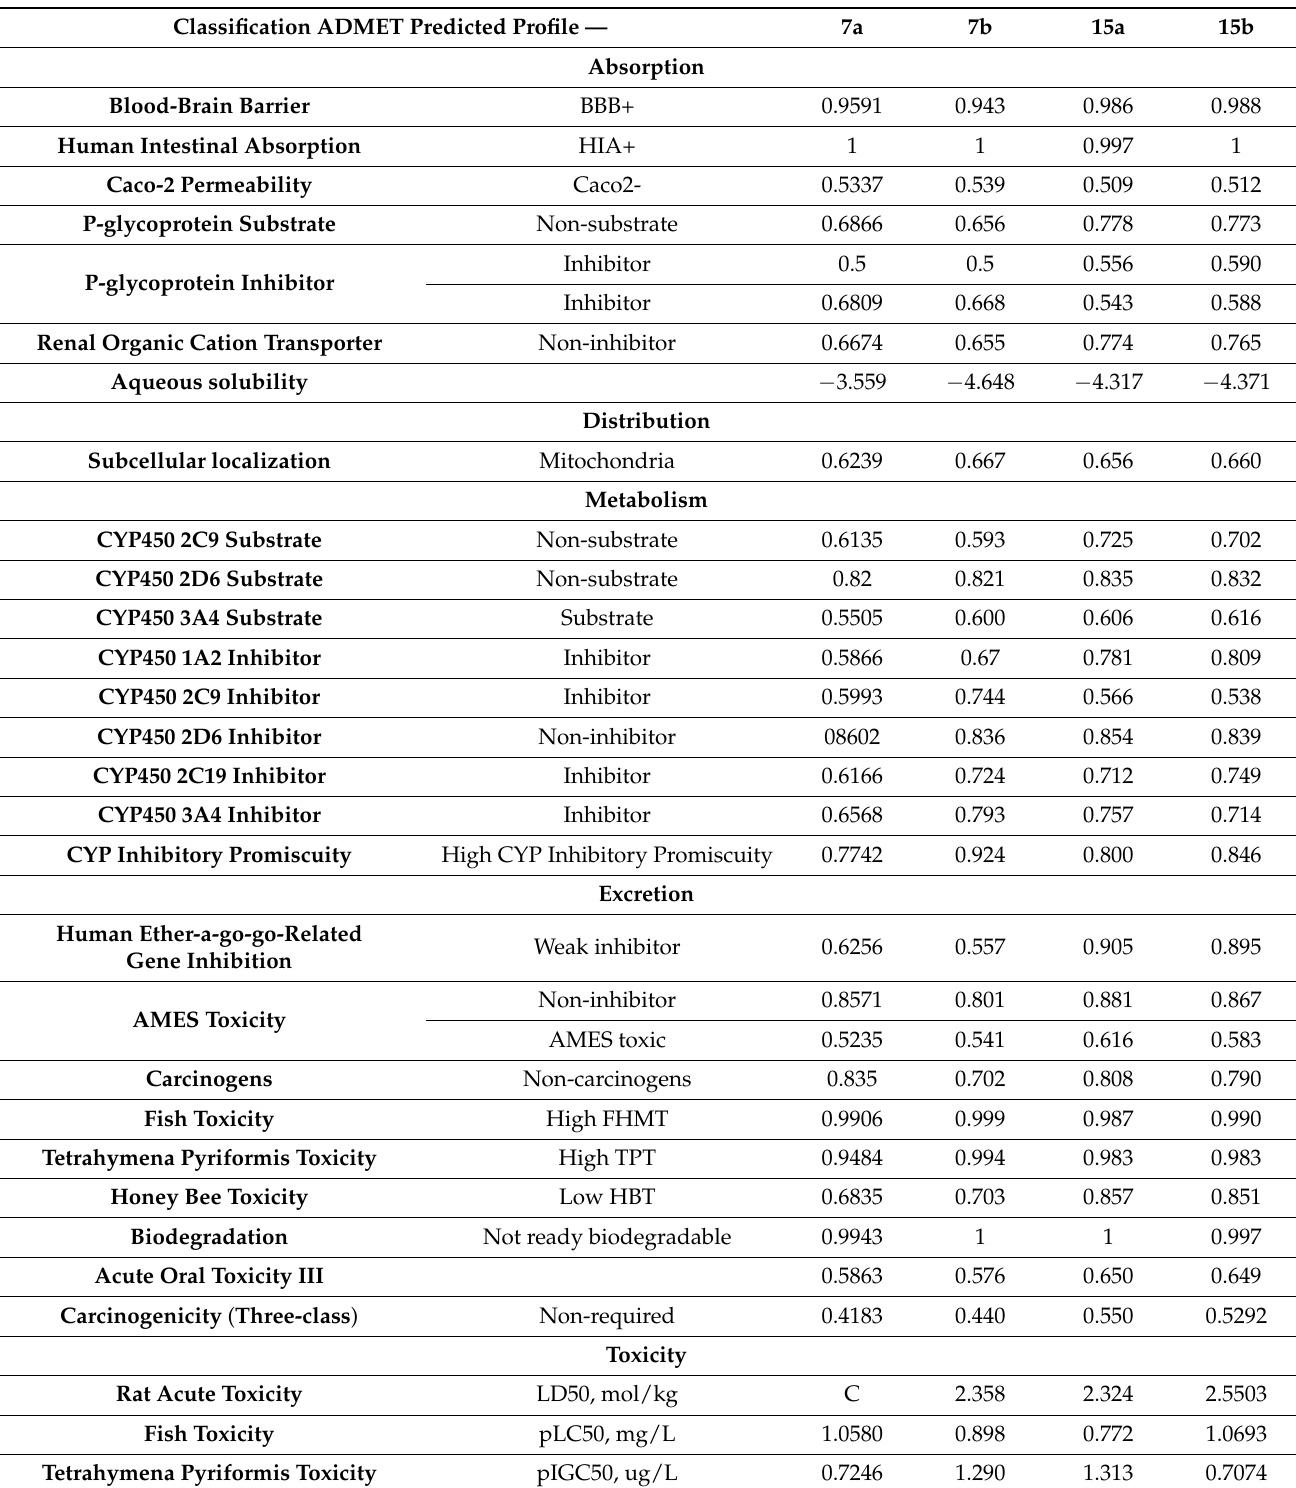
Table 5. Pharmacokinetic parameters for ligands 2 derived from the MOE and ADME-Tox. Classification ADMET Predicted Profile